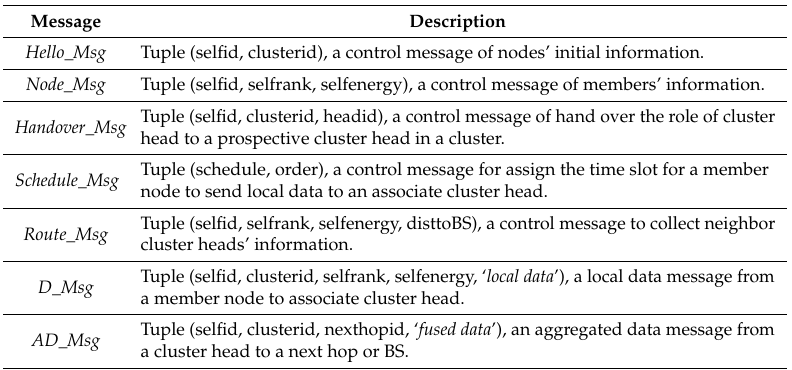
Table 2. Description of the control and data